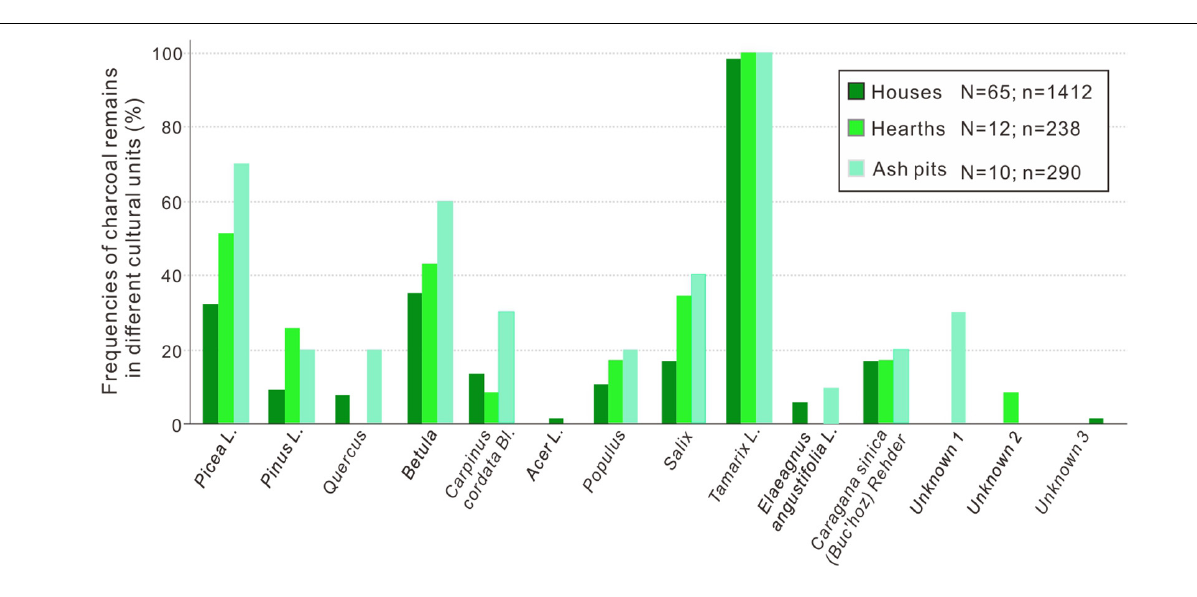
FIGURE 5 | Frequencies of woody taxa in different cultural contexts at